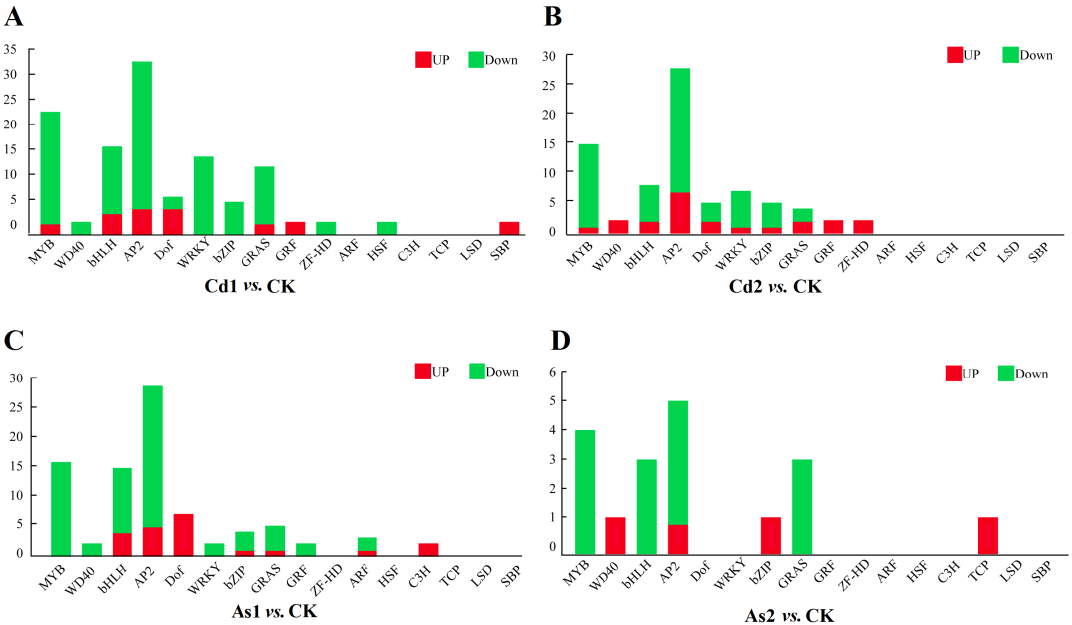
Figure 5. Differentially expressed TFs in Cd/As-treated tea roots. ( A – D ) Differentially expressed TFs in four different pairwise comparisons. ( A ) Cd1 vs. CK ( B ) Cd2 vs. CK; ( C ) As1 vs. CK; ( D ) As2 vs. CK. CK, control group; Cd1 and Cd2 indicate the tea roots treated with Cd for 10 and 15 days, respectively; As1 and As2 indicate the tea roots treated with As for 10 and 15 days, respectively. The red and green rectangles represented the upregulated and downregulated transcription factors, re- spectively.